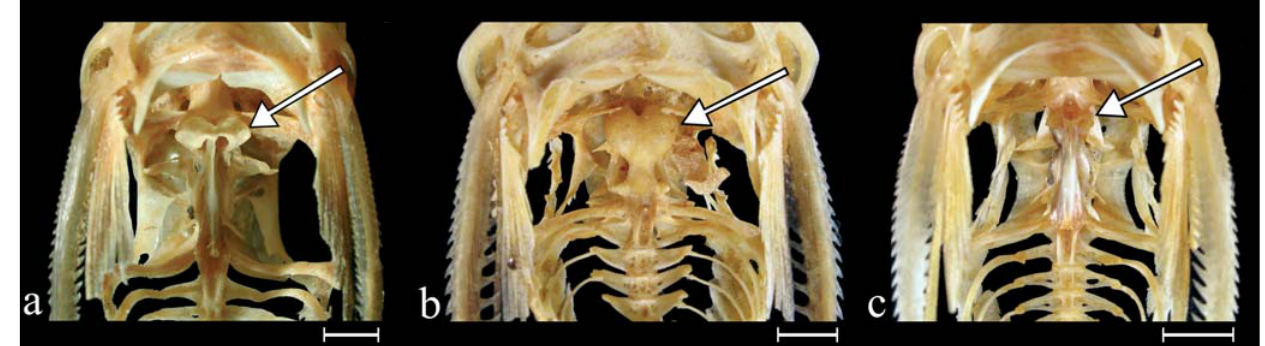
Fig. 6. Anteriormost vertebrae, in ventral view, showing the bony capsules (arrows) of (a) Anduzedoras oxyhynchus , ANSP178551, 138 mm SL, and (b) Leptodoras cataniai , ANSP 179242, 157 mm SL, and cup-like expansions in (c) Leptodoras oyawakai , ANSP 187336, 120 mm SL. Scale bar 5 mm.